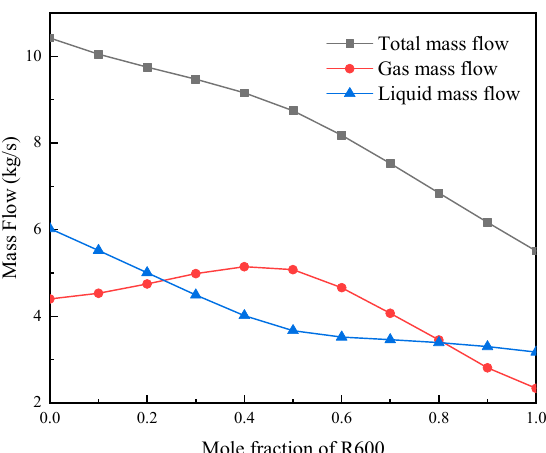
Figure 7. Variation of the total mass flow rate of the working fluid and the mass flow rate of the gas phase and liquid phase with the R600 mole fraction.